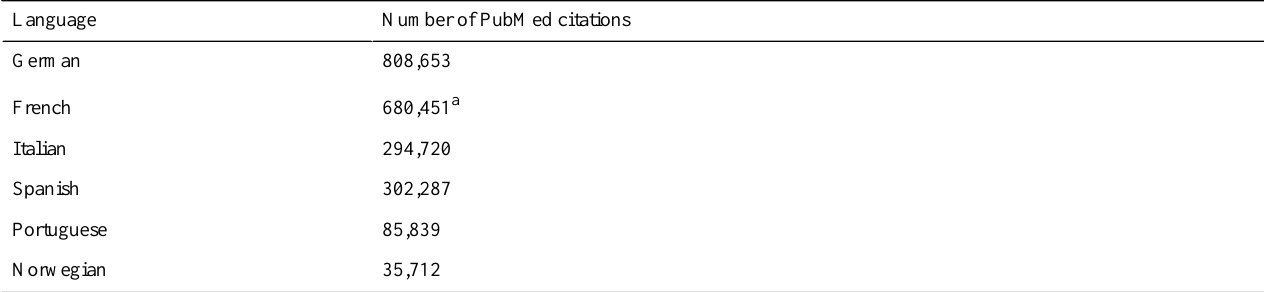
Table 2. Number of PubMed citations for the main European languages.